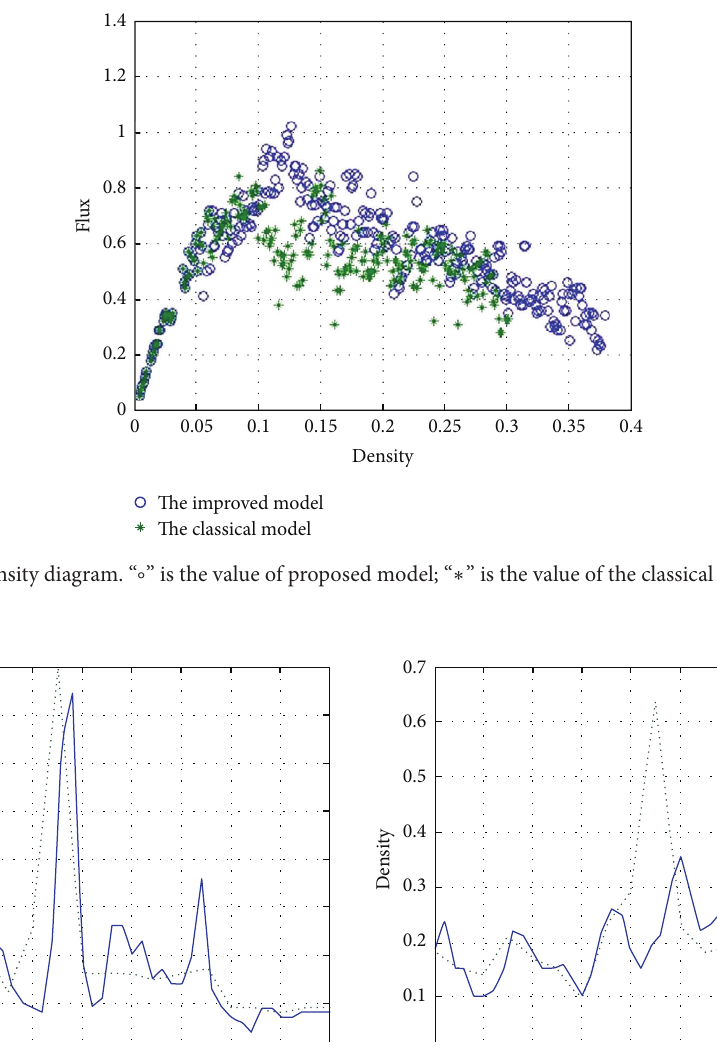
the density distribution of solid line is much more evenly than the density distribution of dotted line. Density peak of dotted line appears at the upstream of bus station; this is mainly because unsuccessful changing lane buses are queuing stint